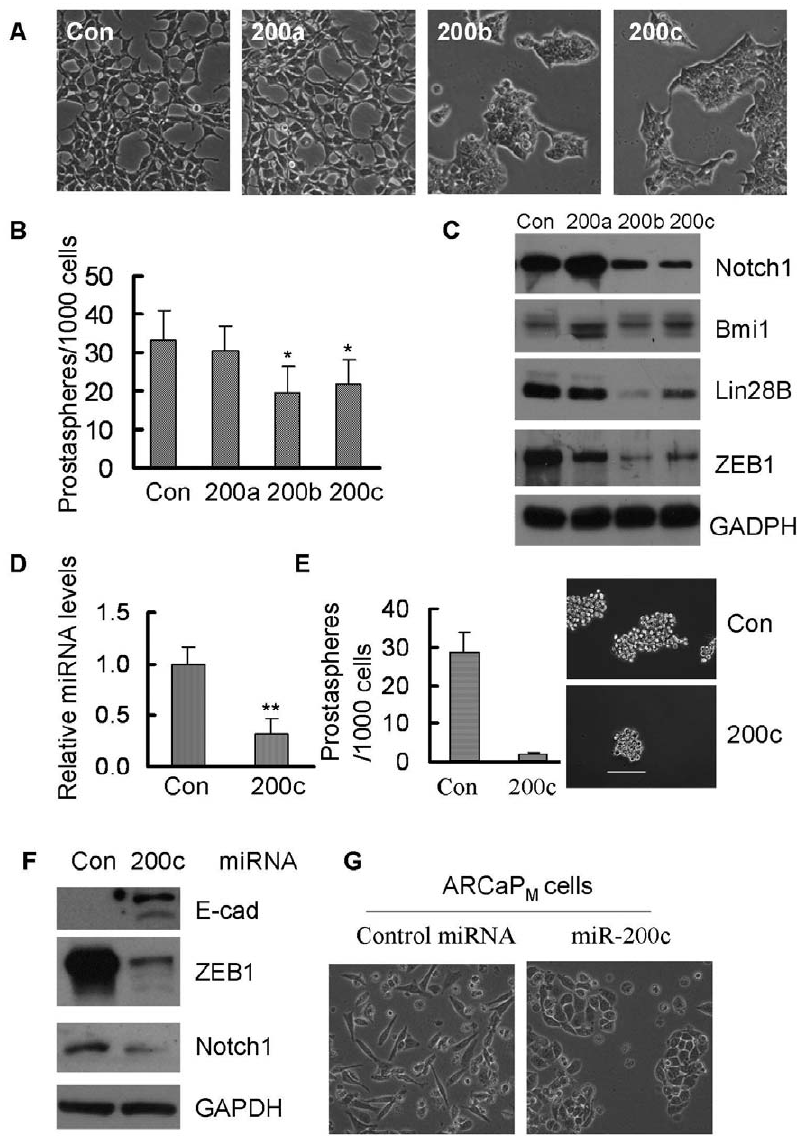
Figure 4. MiR-200 repressed the self-renewal capacity by regulating Notch1 and Lin28B expression. PC3 PDGF-D cells were transfected with pre-miR-200. 3 days after transfection, cells were split and transfected repeatedly with pre-miR-200 every 3–4 days for 14 days. (A) Photographs of cells are shown: transfection of PC3 PDGF-D cells with pre-miR-200 for 14 days, miR-200b and miR-200c reversed EMT cells to MET cell morphology. (B) The cells were collected for generation of prostaspheres after 14-day transfection with pre-miR-200. MiR-200b and miR-200c reduced the number of prostaspheres. (C) Western Blot showing that Notch1, Lin28B and ZEB1 expressions were down-regulated in PC3 PDGF-D cells transfected with miR-200b and miR-200c. (D) The level of miR-200c significantly decreased in ARCaP M by using real time RT-PCR. (E) Transfection of pre-miR-200c after 6 days reduced the prostasphere-forming ability in ARCaP M cells (Bar:100 m m). (F) Western blot showed that re-expression of miR-200c by transfection of pre-miR-200c increased the E-cadherin expression and repressed expression of ZEB1 and Notch1 in ARCaP M cells, which consistent with the change from mesenchymal to epithelial cell morphology (G). *, p , 0.05 compared to control; **, p , 0.01 compared to control. (Con: control, 200a: pre-miR- 200a, 200b: pre-miR-200b, 200c: pre-miR-200c, E-cad: